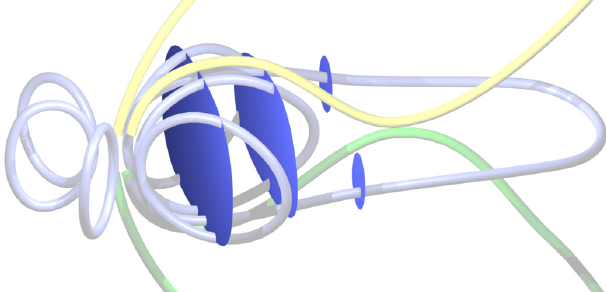
Fig. 6. The areas of closed magnetic field lines in three different x-planes added into Fig. 2.